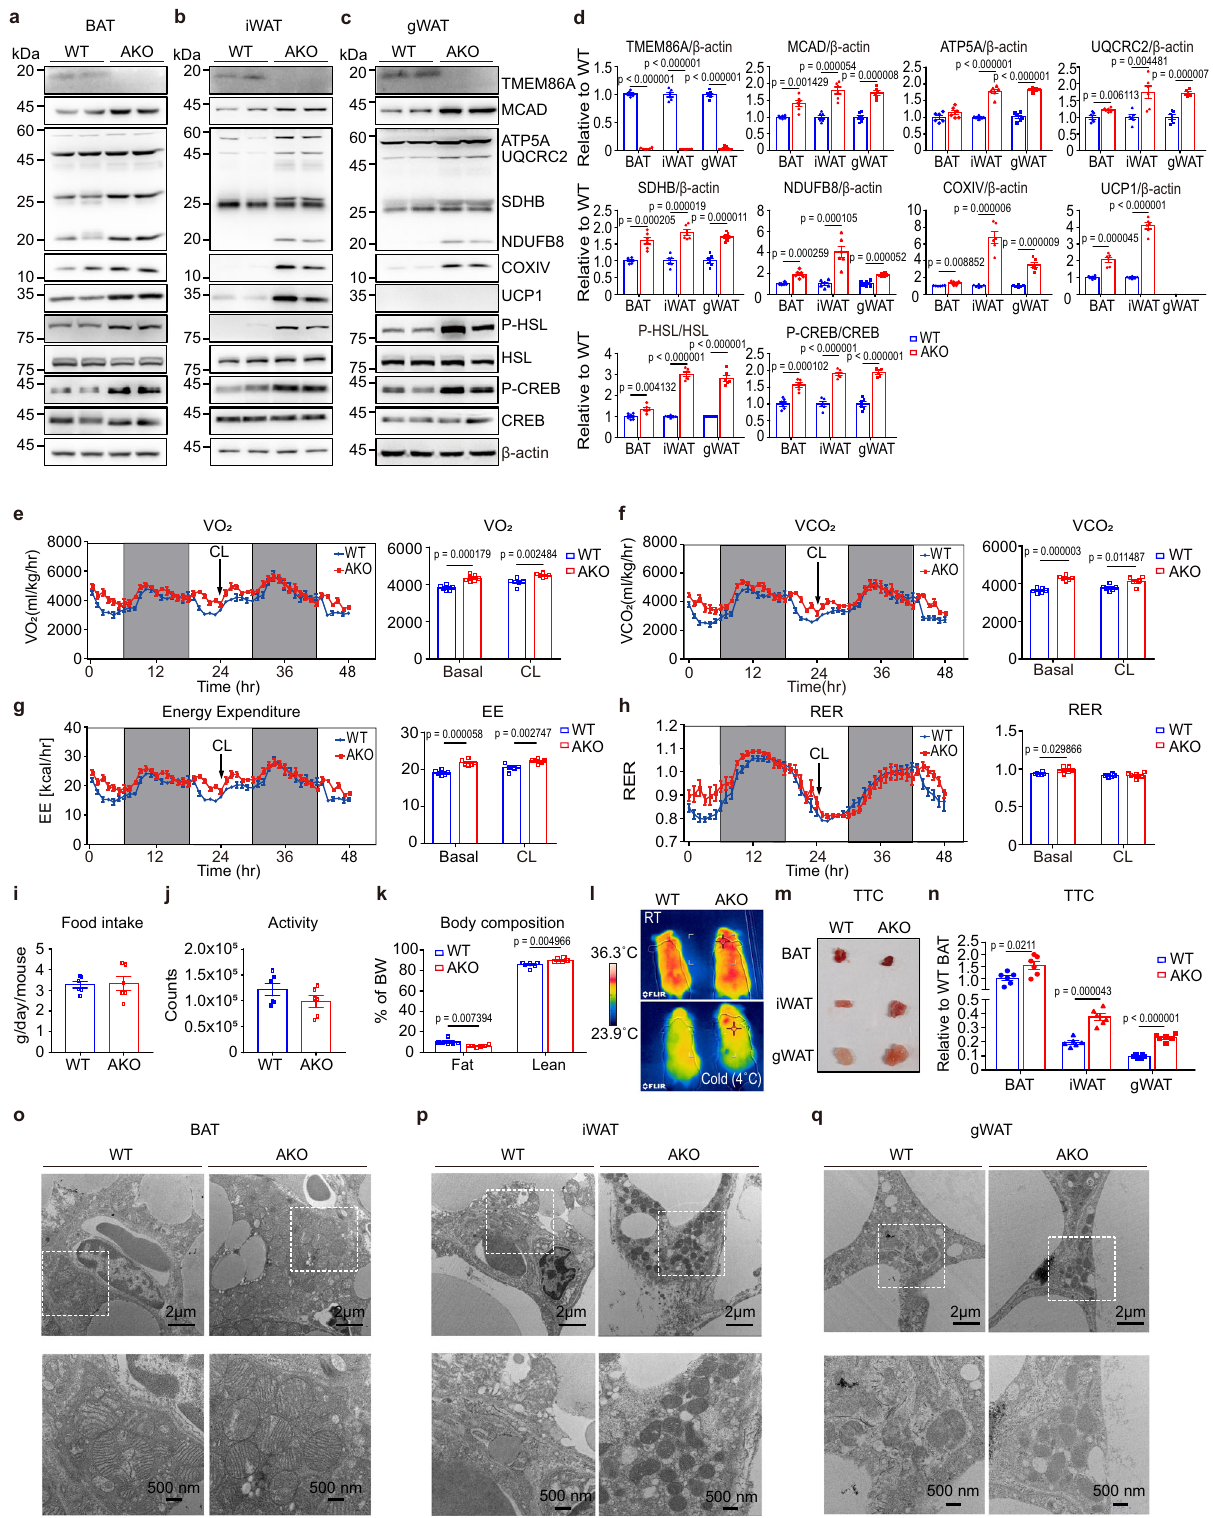
Fig. 4 Adipocyte-speci fi c knockout of TMEM86A enhances PKA-signalling pathway and mitochondrial oxidative metabolism in adipose tissue. a – d Immunoblot analysis of BAT, iWAT and gWAT of WT and TMEM86A AKO mice. n = 6. e – h Indirect calorimetry analysis. Arrows indicates CL316,243 (CL) injection. EE: energy expenditure; RER: respiratory exchange ratio; VO 2 : rate of oxygen consumption; VCO 2: rate of carbon dioxide production. n = 6. i , j Monitoring of food intake and activity. k Body fat and lean mass. n = 6. l Infrared thermal images showing skin temperature at room temperature or after 60 min of cold exposure (4 °C). n = 4. m , n Triphenyltetrazolium chloride (TTC) staining of BAT, iWAT, and gWAT and quanti fi cation. n = 6. o – q Electron microscopy of BAT, iWAT and gWAT. Boxed regions are magni fi ed. n = 6. Each point represents a biological replicate. Data are presented as the mean ± SEM. Statistical signi fi cance was determined using the unpaired, two-tailed t -test in d – j and n . Source data are provided as a Source Data fi